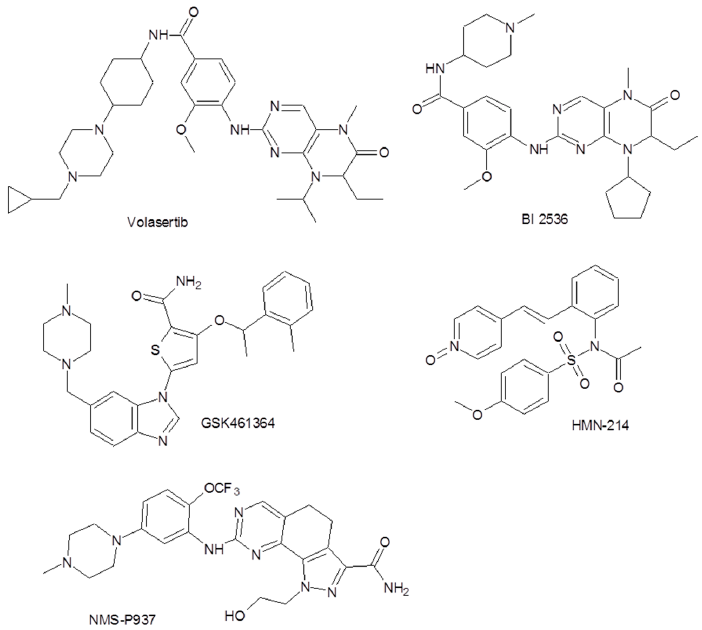
Figure 1. Some polo-like kinase-1 (PLK1) inhibitors involved in current clinical trials [5].